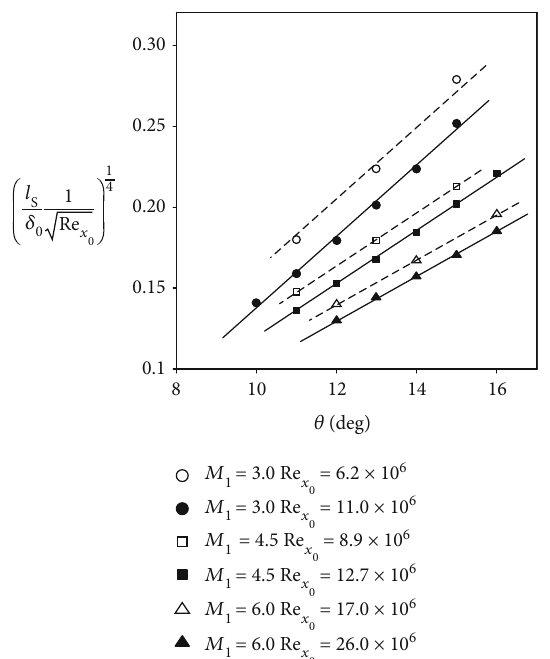
Figure 8: In fl uence of the Reynolds number on the separation length.